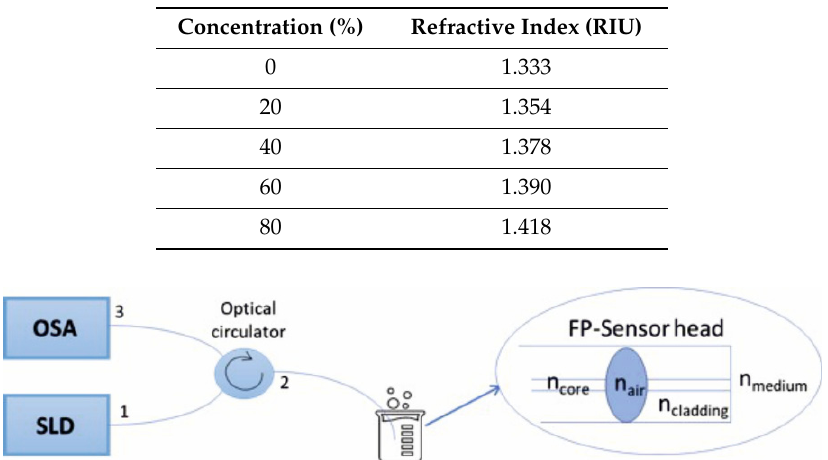
Table 1. Refraction indices used for sensor calibration and their relation to the ethylene glycol concentration. Concentration (%)